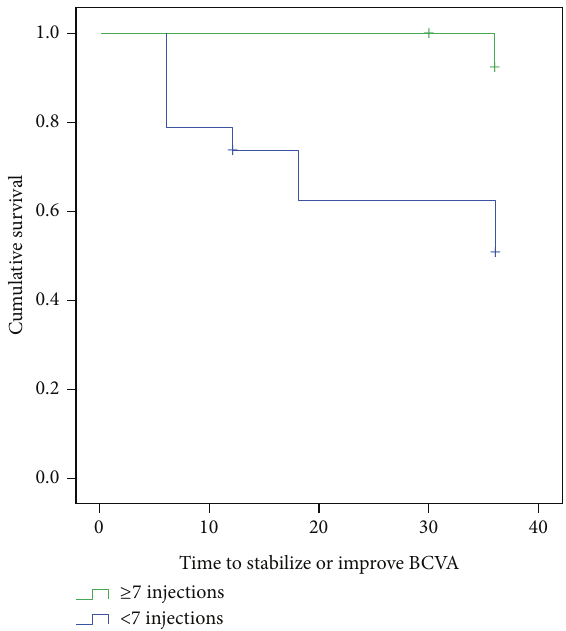
Figure1:Kaplan-MeiersurvivalplotsofstableBCVA(SRwas92.9% in patients who received 7 or more injections versus 51.4% in those treated with < 7 treatments ( 𝑃 = 0.008 ; log-rank